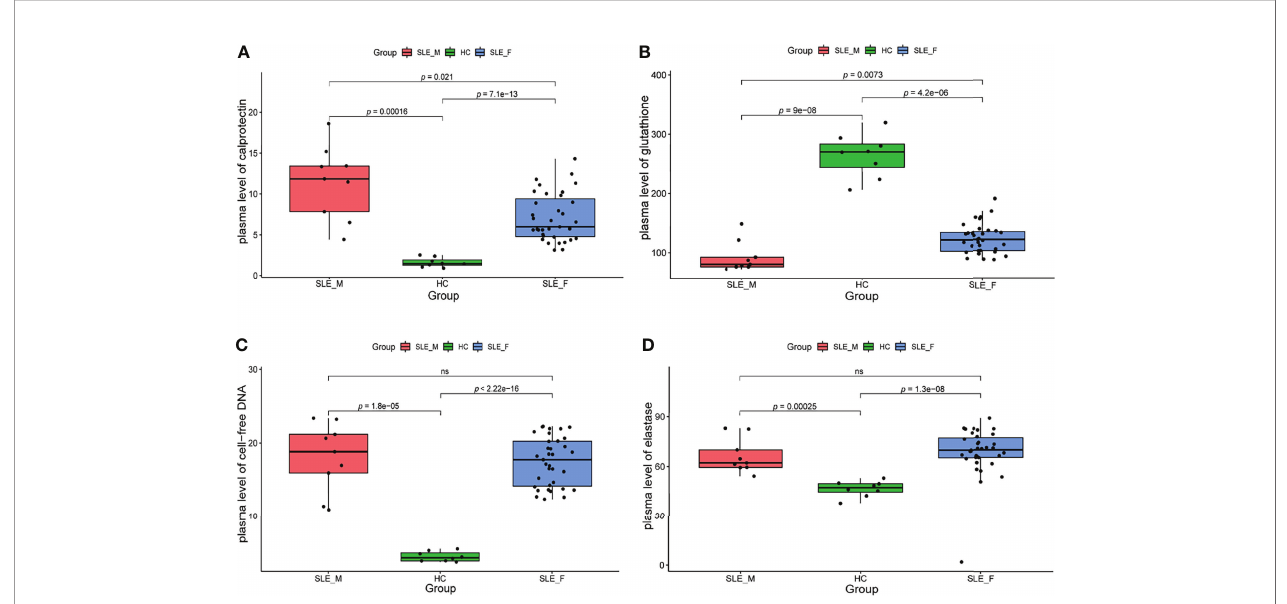
FIGURE 7 | The level of neutrophil activation and oxidative stress is higher in male SLE. (A) Boxplot showing serum level of calprotectin in male SLE, female SLE, and healthy control. (B) Boxplot showing serum level of glutathione in male SLE, female SLE, and healthy control. (C) Boxplot showing serum level of cell-free DNA in male SLE, female SLE, and healthy control. (D) Boxplot showing serum level of elastase in male SLE, female SLE, and healthy control. ns, not signi fi cant.